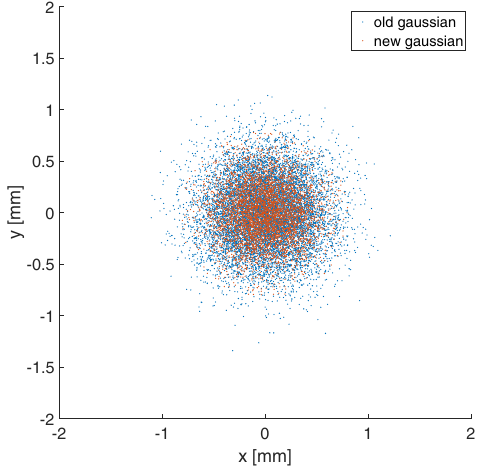
FIG. 13. An example intensity distribution of the UV laser recorded with a virtual cathode at the exact same position from the laser generator to the actual magnesium cathode: In order to maintain the required power for high bunch charge generation over the time of a measurement, the laser beamline especially the UV conversion section had to be realigned, thus changing the exact shape of the distribution as well. Compare Fig. 14 for a numerical representation.